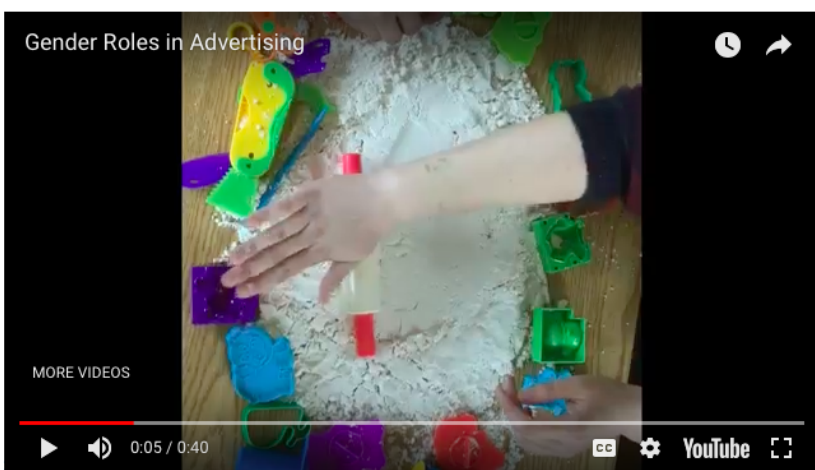
Figure 1. Student mentor video depicting neutral gender roles in advertising for children. dividual child doesn’t fit into the roles on offer in the media. This unit gives students the opportunity to crit- ically analyze factors that may have shaped their own sense of